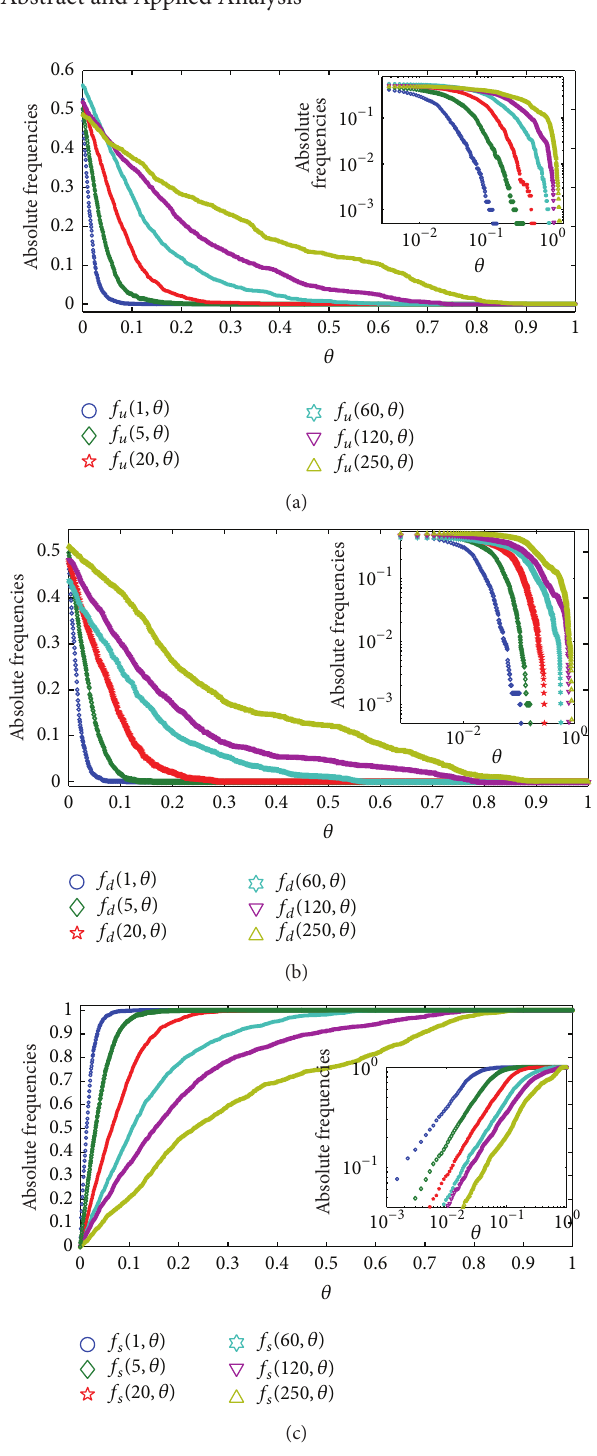
Figure 2: The evolution trends of absolute frequencies of the actual data for the simulation data for the financial model with the random variable 𝜃 . Plots (a), (b), and (c) are the absolute frequencies of price-up, price-down, and price-stable, respectively. The insets are the corresponding double logarithmic